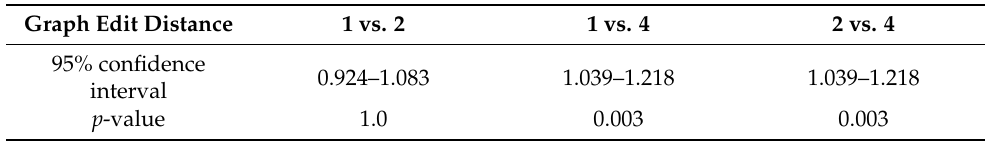
Table 5. Results of the F-test for the equality of variance of the estimated mixture proportions between different values of the graph edit